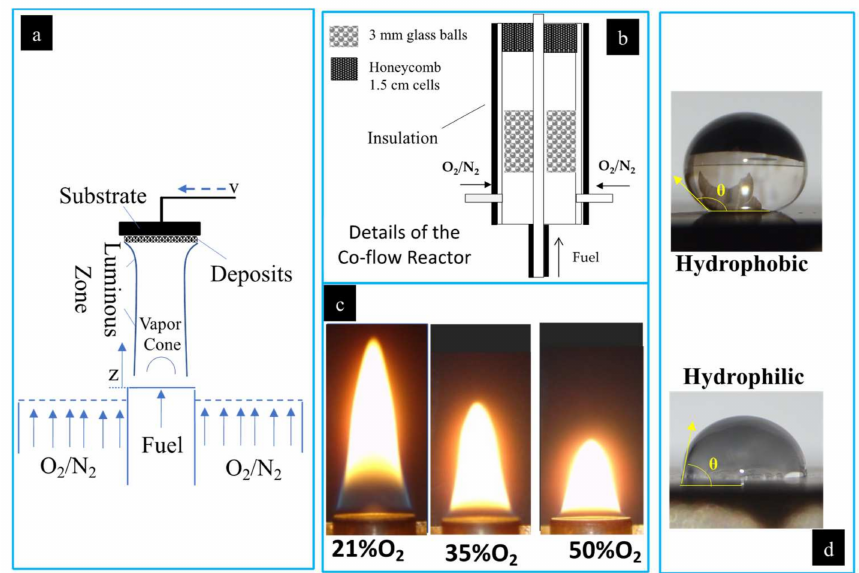
Figure 2. Experimental setup is shown. ( a ) Two-dimensional representation of the deposition process of soot on an SS substrate from the co-flow flame; ( b ) detailed co-flow reactor schematic; ( c ) photo- graph of the CME/oxygen-enriched air flame at O 2 contents of 21%, 35%, and 50%; ( d ) photographs of water droplets on a hydrophobic and hydrophilic surface with contact angles